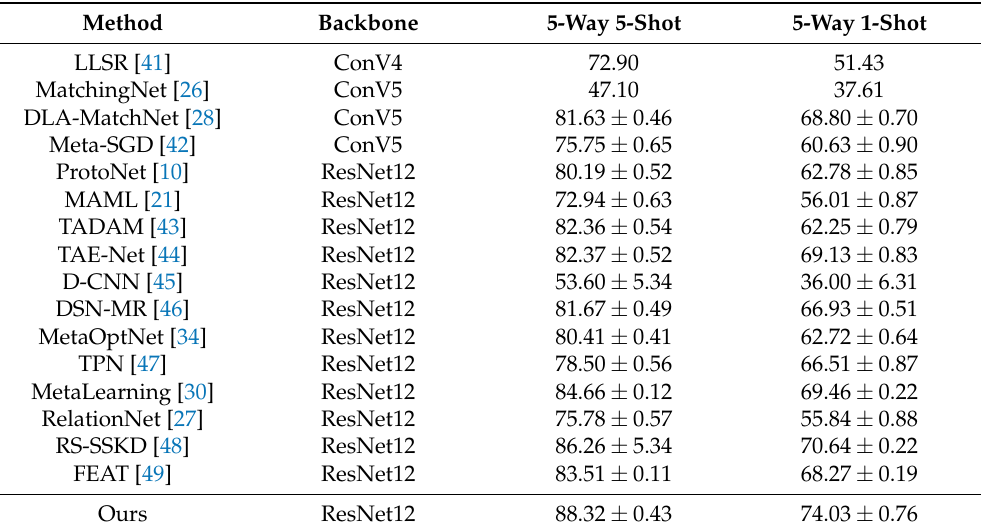
Table 2. The few-shot classification accuracies with 95% confidence intervals over 600 episodes in the NWPU-RESISC45.